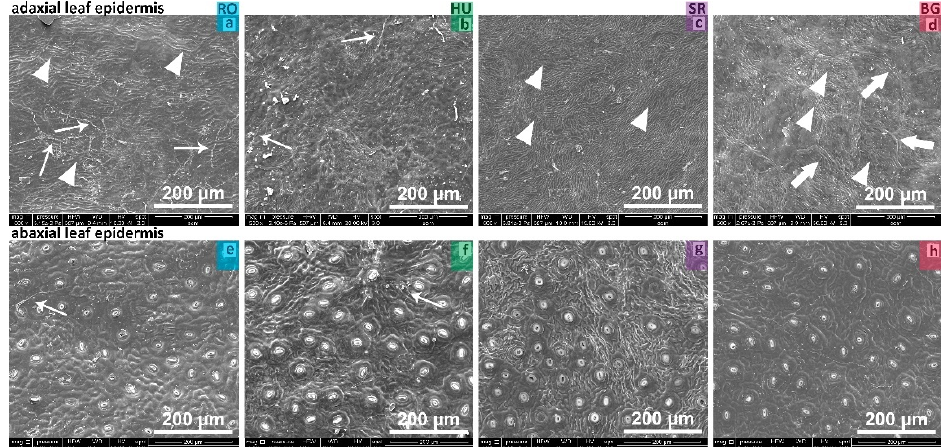
Figure 3. Adaxial and abaxial leaf surfaces, SEM assessment of the morphological aspects. Fine cuticle striations were markedly visible in case of RO, SR and BG samples (( a , c , d ) arrow heads); pentagonal or hexagonal shaped cells (( d ), thick arrows) and fungal hives present on the adaxial and abaxial surfaces of both the HU and RO samples (( a , b , e , f ), thin arrows), evident stomata presence ( g , h ). The abaxial epidermis of the analyzed leaves exhibited cuticular striations to different extents, such that the phenotypic strength of each sample could be described on a scale from more to less pronounced. In case of the HU and SR leaves, the cuticular